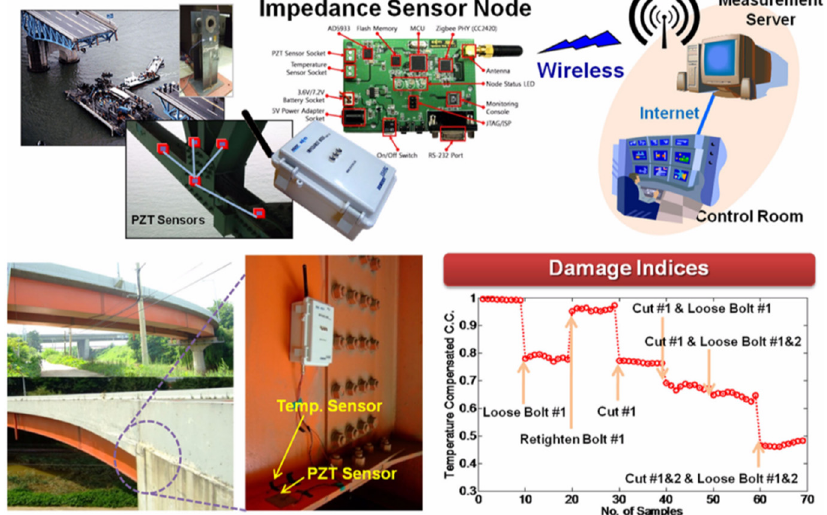
Figure 15. Impedance sensor node for damage detection on bridge [185].